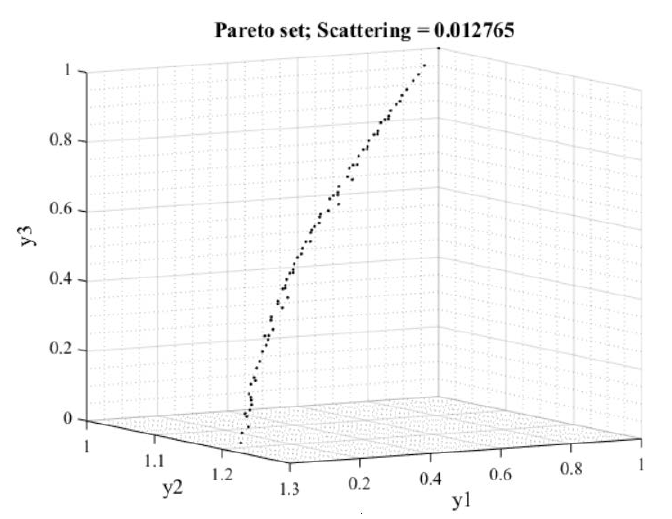
Figure 6. Three-dimensional plot of Pareto frontier—case-study II. The obtained Pareto-set presents two prevailing buses for installation of photovoltaic plants: for PV-01 type, 47% of the individuals propose bus 565 with 440 kWe of aver- age power and 42% suggest bus 666 with 1440 kWe of average power; for PV-02 type, predominance is in bus 468 (95% of individuals) with an average power of 1265 kWe. Complementarily, the pair of buses 565–468 is in 47% of individuals and the pair 666–468 in 38%, totalizing 85% of solution alternatives from Pareto-set. Normalized objective functions plotted two by two in Figure 7 and observation of curvature in y1-y2 and y2-y3 planes indicate over again that minimization of installation costs and of CO 2 emissions are conflicting with minimization of network power losses.